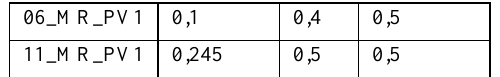
Table 4. Intensity values data tested during the